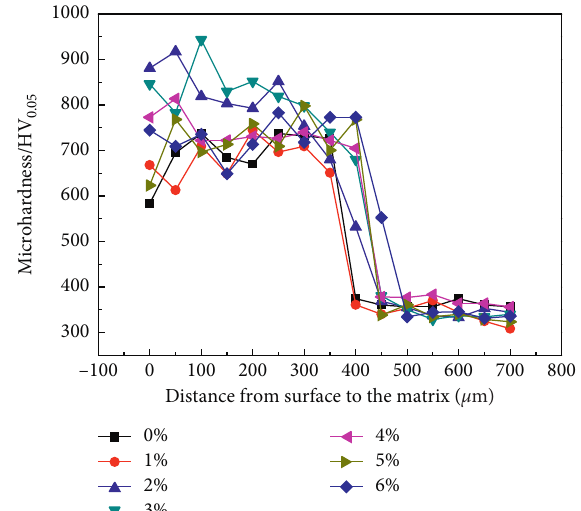
Figure 6: The microhardness distribution curves of laser-cladding coatings with various CeO 2 contents.